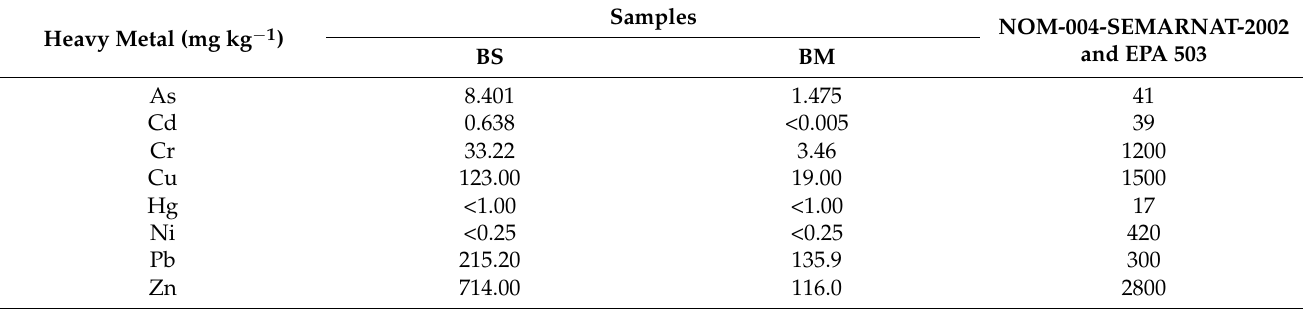
Table 1. Concentration of heavy metals in BS and